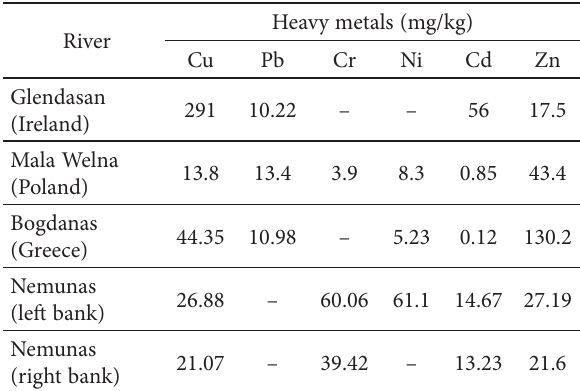
Table 1. Comparison of HM concentrations in Nemunas river